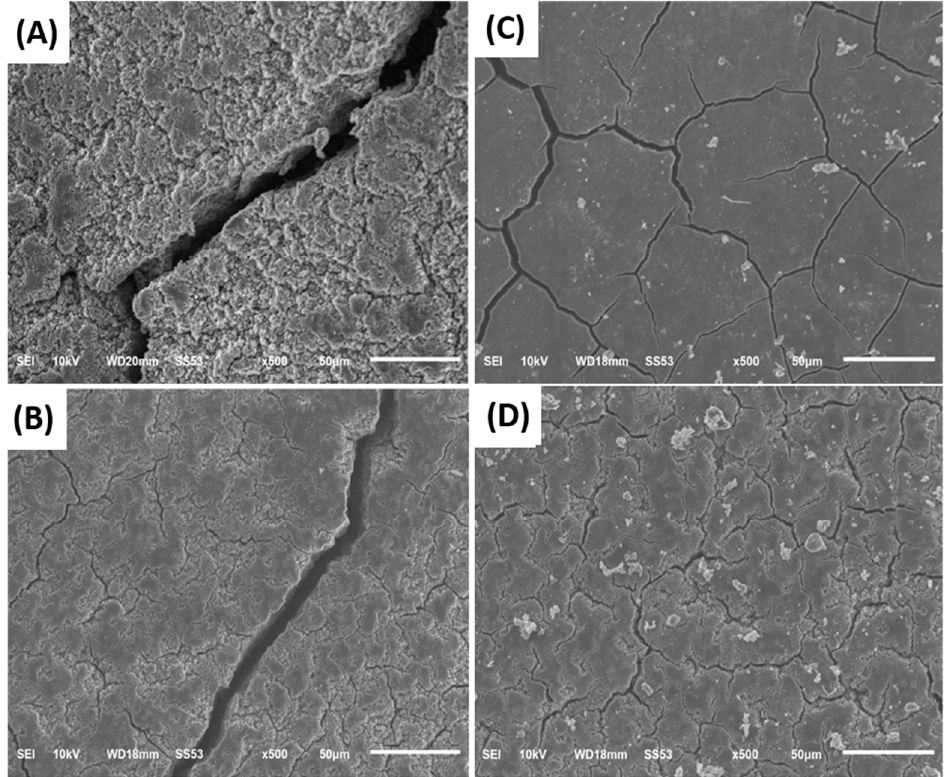
Figure 14. SEM image of the surface of cycled anodes made of: ( A ) Si:KB:binder = 70%:10%:20% by weight without pyrolysis, ( B ) Si:Super P:binder = 70%:10%:20% by weight without pyrolysis, ( C ) Pyrolyzed Si:KB:binder = 70%:10%:20% by weight, and ( D ) pyrolyzed Si:Super P:binder = 70%:10%:20% by weight. The anodes were cycled 200 times.